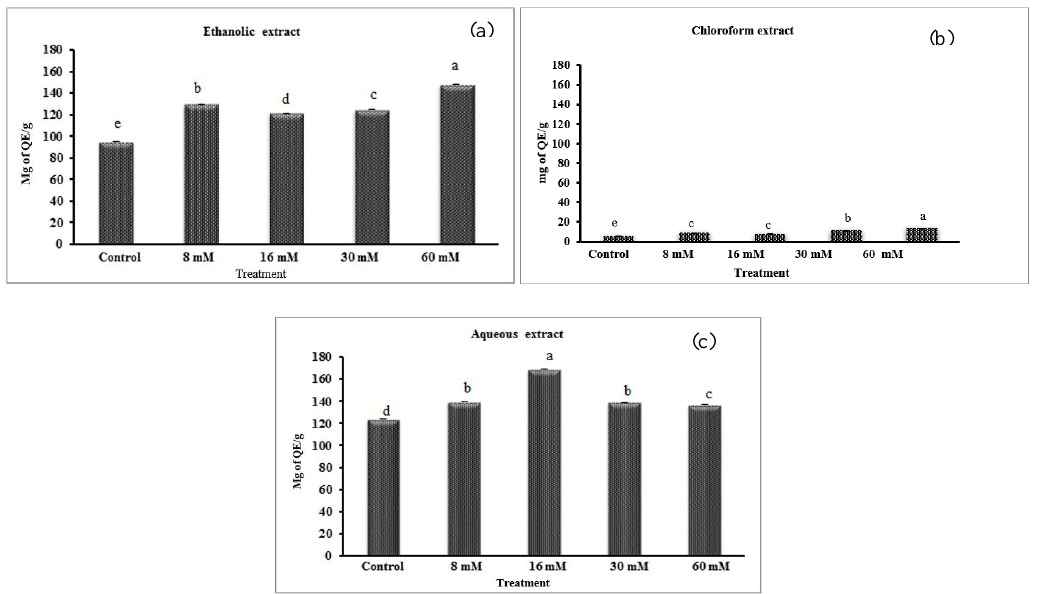
Figure 4. E ff ect of H 2 O 2 on total flavonoid content in leaf of Ficus deltoidea var deltoidea under di ff erent solvent extractions; ( a ) ethanolic extract, ( b ) chloroform extract and ( c ) aqueous extract. Bars indicate ( ± S. E). Di ff erent letters represent the significance at the 5% level of HSD test.